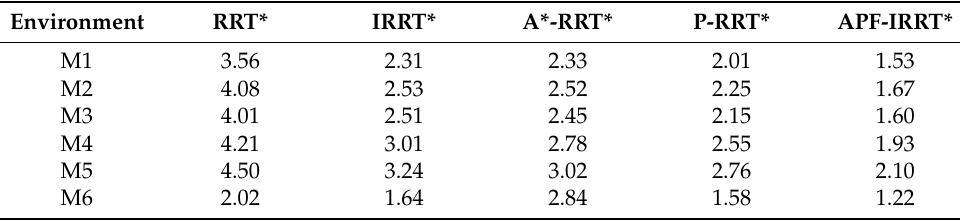
Table 2. The mean value of search time for 20 independent simulations of RRT*, IRRT*, A*-RRT*, P-RRT* and APF-IRRT* algorithms.